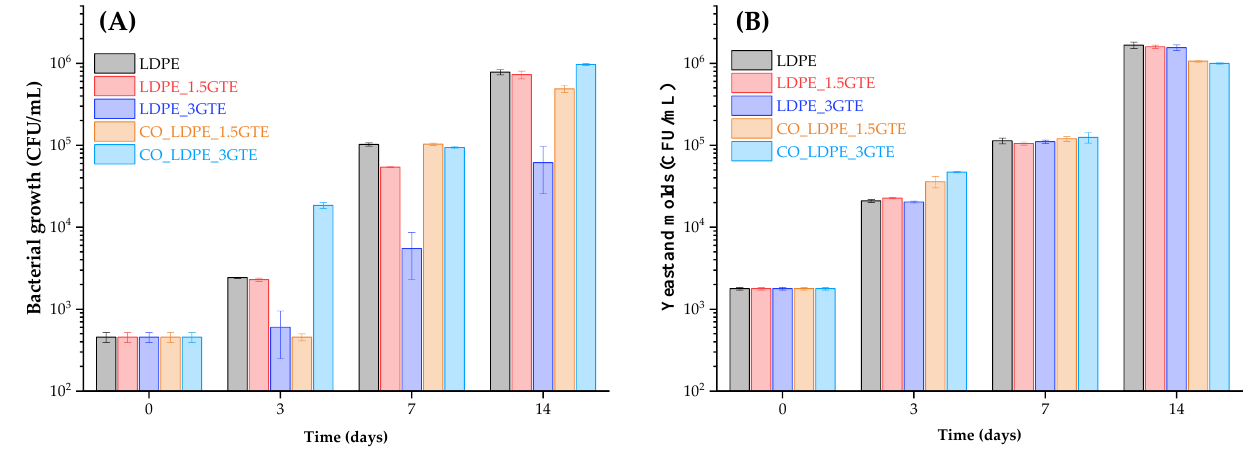
Figure 3. Count of bacterial (A) and yeast and molds (B) growth in orange juice packed from active LDPE films containing GTE stored at 4 °C for 14 days